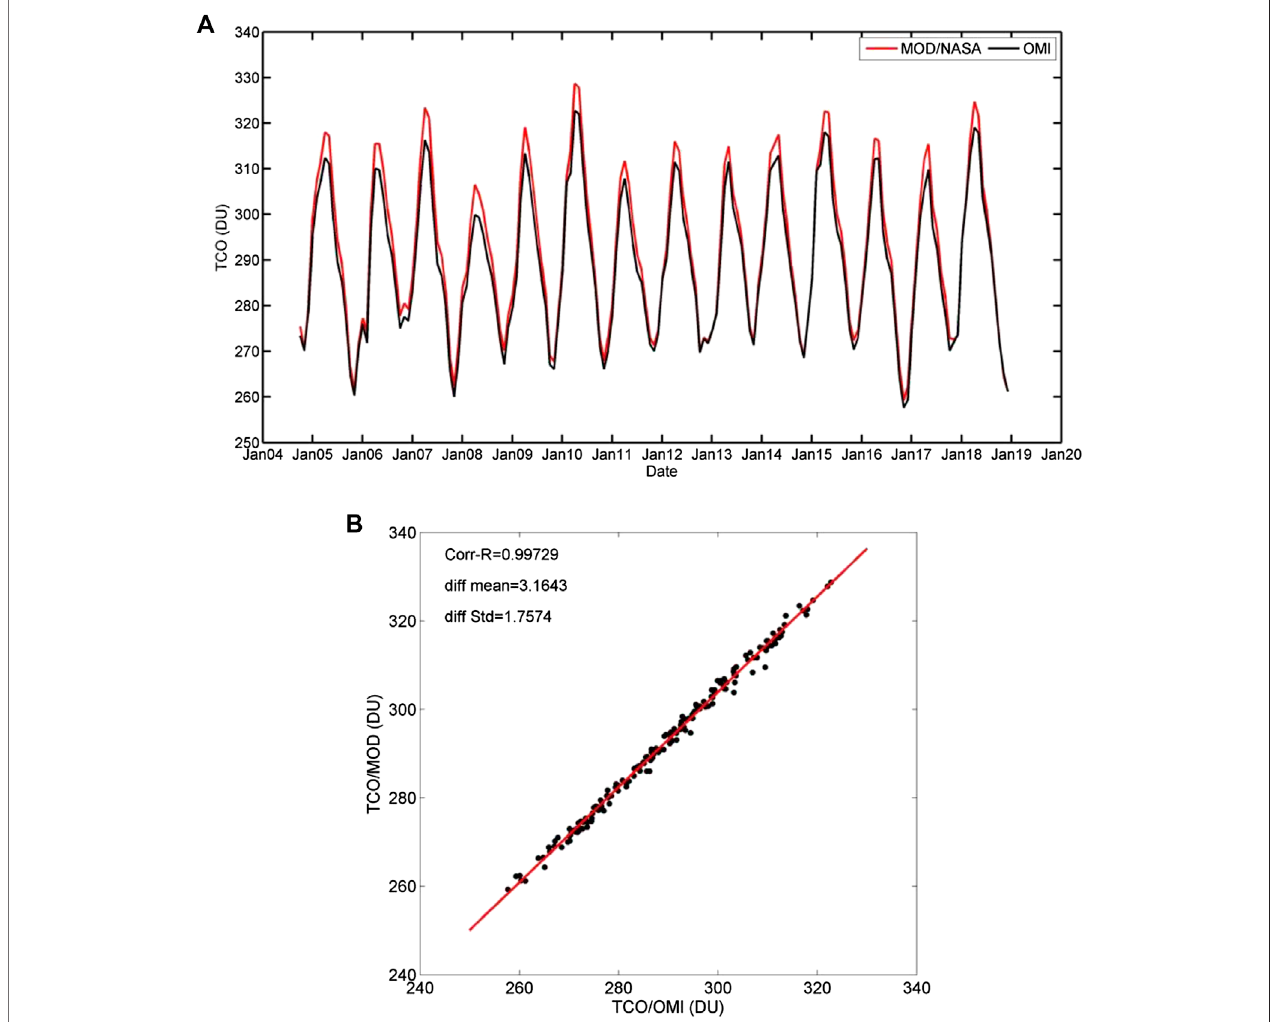
FIGURE 5 | Variation of TCO zonal mean at 30 – 35 ° N from OMI from 2004 to 2019 and its comparison with MOD data in the same period (A) . Scatter plot of the same OMI TCO vs. MOD data is shown in the lower panel (B) .